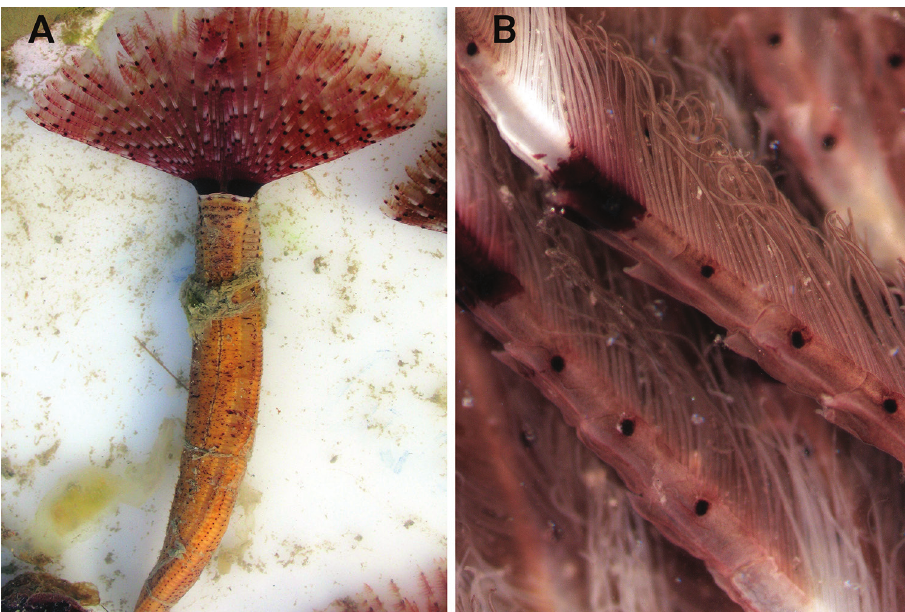
Figure 11. Pseudobranchiomma grandis from New Zealand. A Whole live animal B Section of radioles, showing paired radiolar eyes and serrations of lateral flanges. Photos by Rod